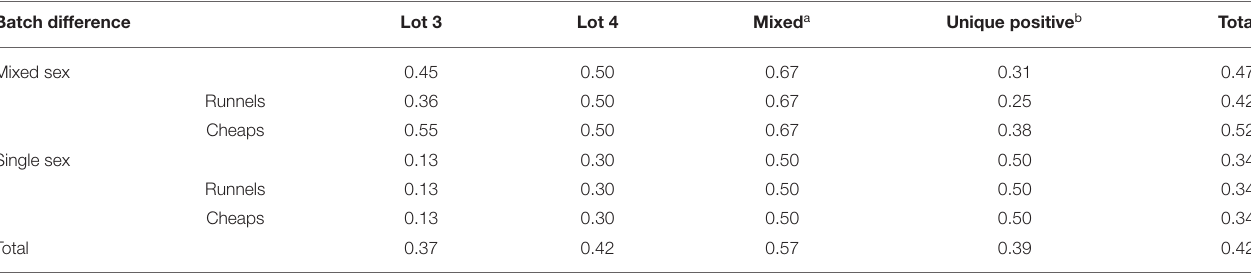
TABLE 3 | Proportion correct responses on 162 total test trials using 41 sets of two negative samples and one positive sample. Batch